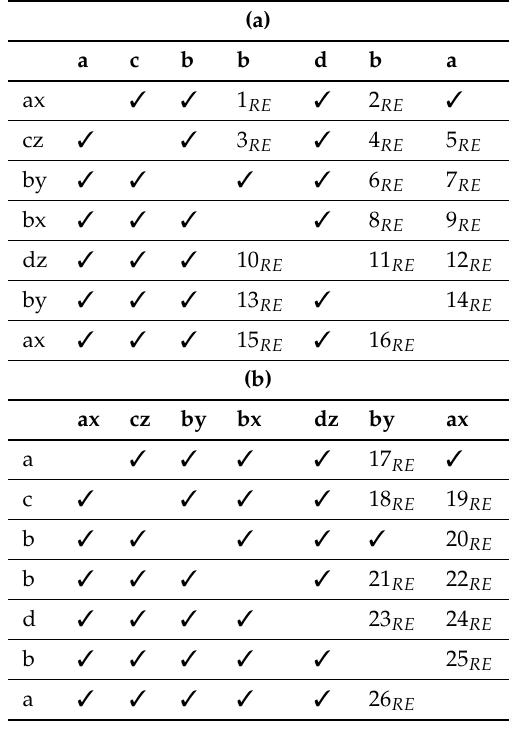
Table 11. MR-I results for respondedExistence constraints: ( a ) activation; and ( b )